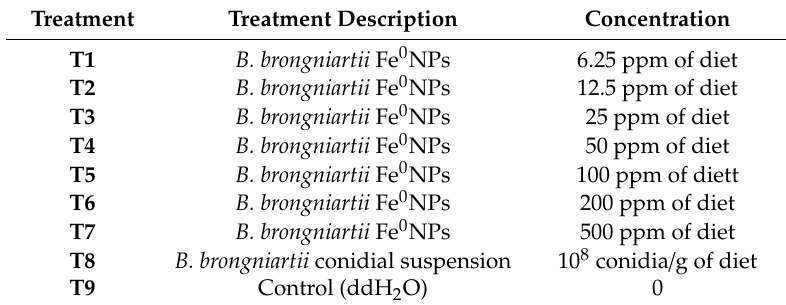
Table 1. Details of di ff erent Beauveria brongniartii Fe 0 nanoparticles and B. brongniartii treatments used in the bio-e ffi cacy studies. Treatment Treatment Description